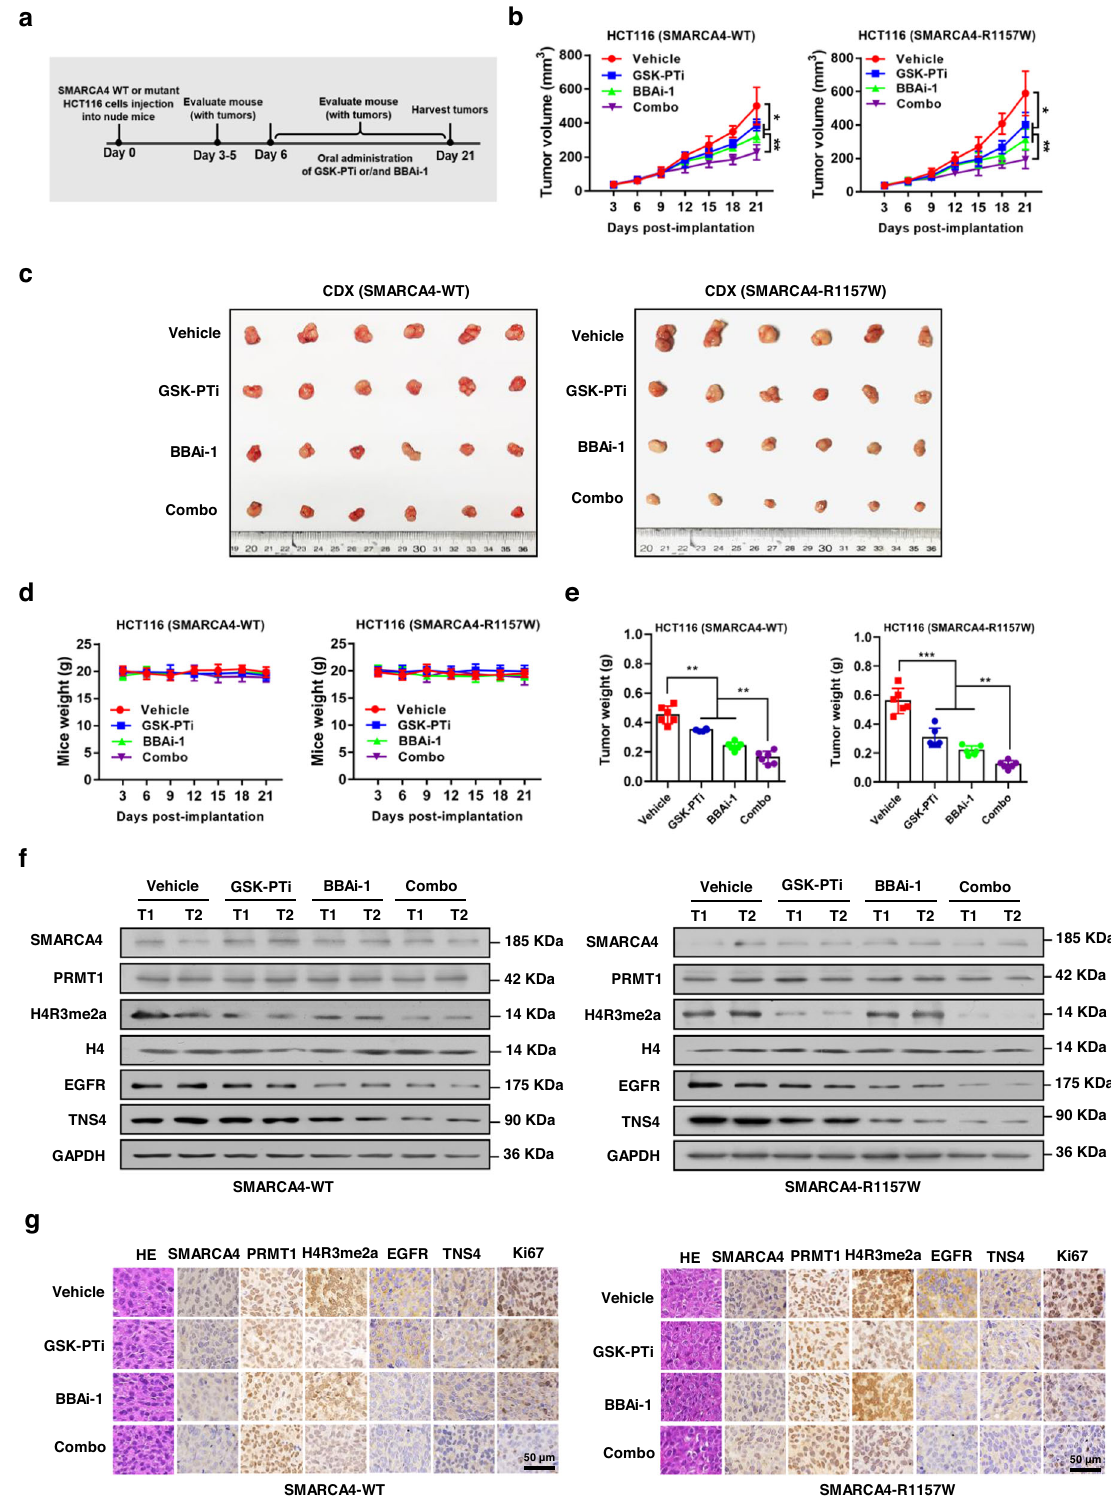
Fig. 6 Synergistic effect of combined treatment with GSK-PTi and BBAi-1 in CDX mouse models of CRC. a Schematic of the strategy used for testing the ef fi cacy of GSK-PTi and BBAi-1 in vivo. b – e Tumor volumes ( b ), tumor images ( c ), mouse weights ( d ), and tumor weights ( e ) of SMARCA4-WT or -R1157W HCT116 cell-derived xenograft tumors excised from mice treated with GSK-PTi (25 mg/kg) or BBAi-1 (2.5 mg/kg) or combination. * P < 0.05, ** P < 0.01, *** P < 0.001. f Western blot analysis of indicated proteins in SMARCA4-WT or -R1157W HCT116 cell-derived xenograft tumors after treatment with GSK-PTi (25 mg/kg) or BBAi-1 (2.5 mg/kg) or combination. g Hematoxylin and eosin (H&E) staining and immunohistochemical staining (IHC) analysis with indicated antibodies in SMARCA4-WT or -R1157W HCT116 cell-derived xenograft tumors after treatment with GSK-PTi (25 mg/kg) or BBAi-1 (2.5 mg/kg) or combination. In the graphs, the error bars are the standard deviation of the